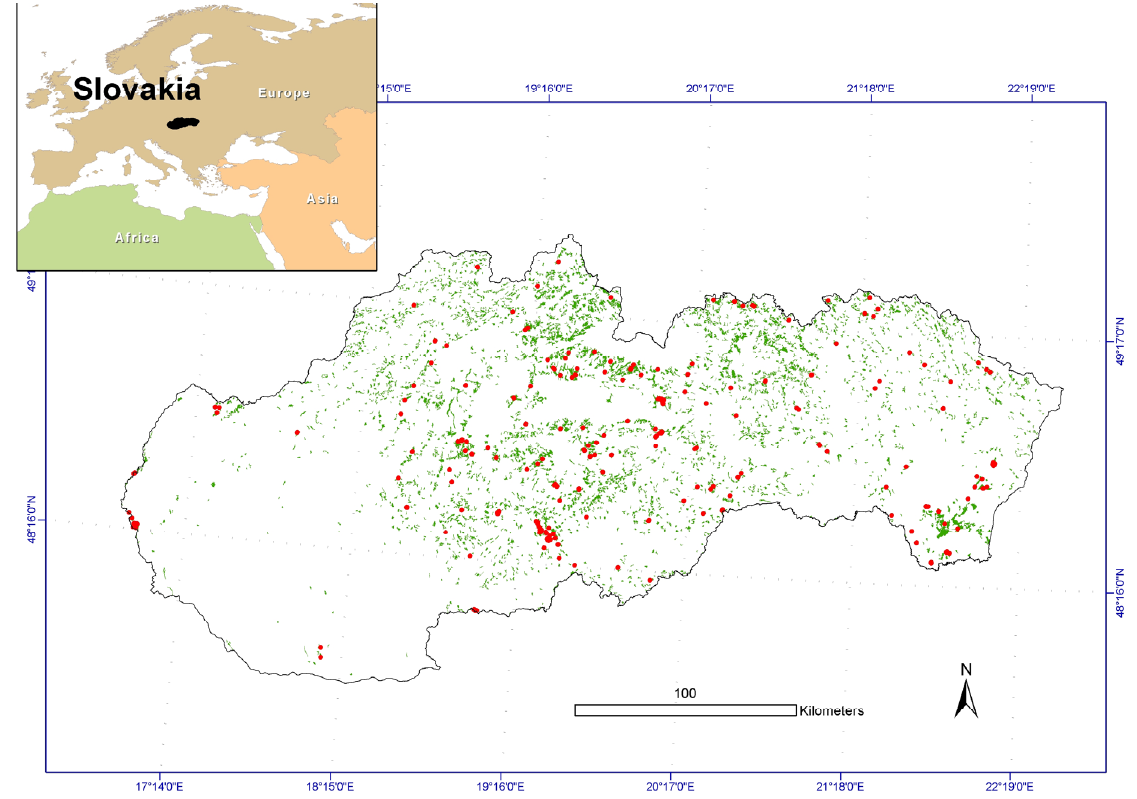
Figure 1. Study area and sampled hay meadows (red dots) that were used for the analyses. Green areas represent all grasslands in Slovakia (Corine Land Cover class 231